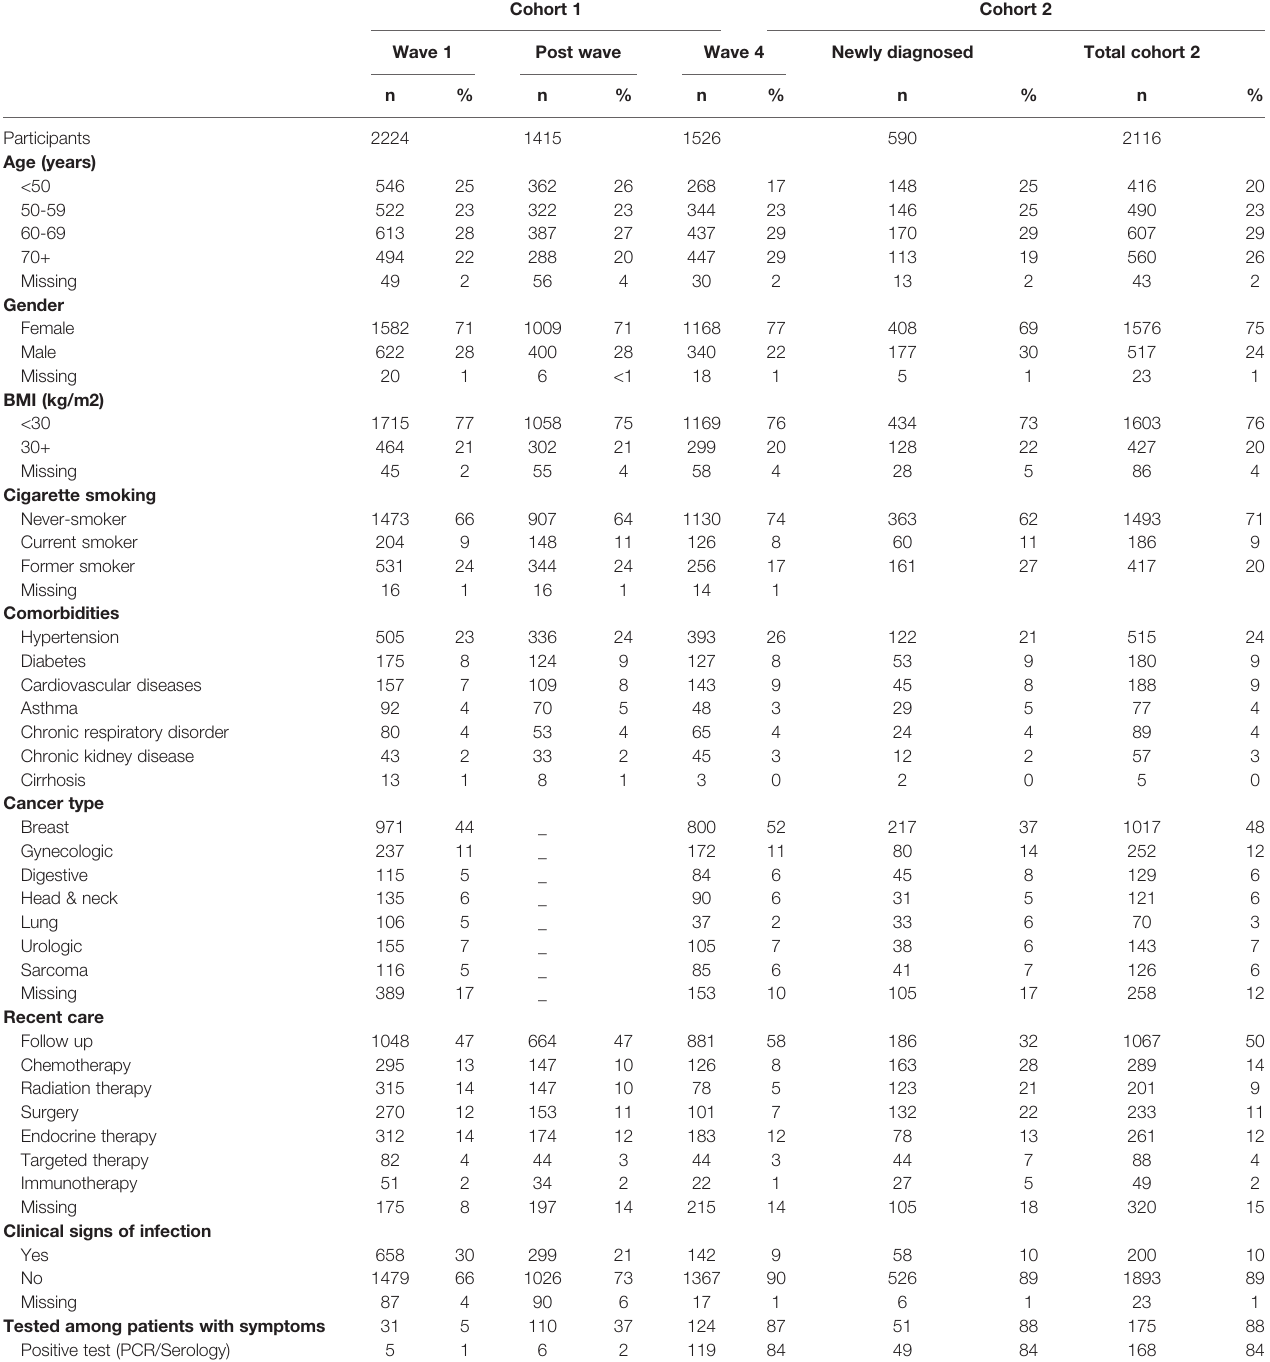
TABLE 1 | Patients ’ characteristics and COVID-19 infection in cohorts 1 and